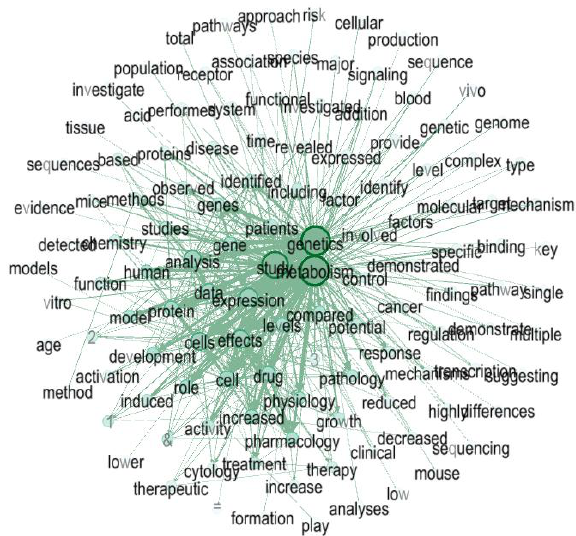
Figure A5. Co-occurrence network of high-frequency words within the bioinformatics literature ( K = 1000, E = 500).